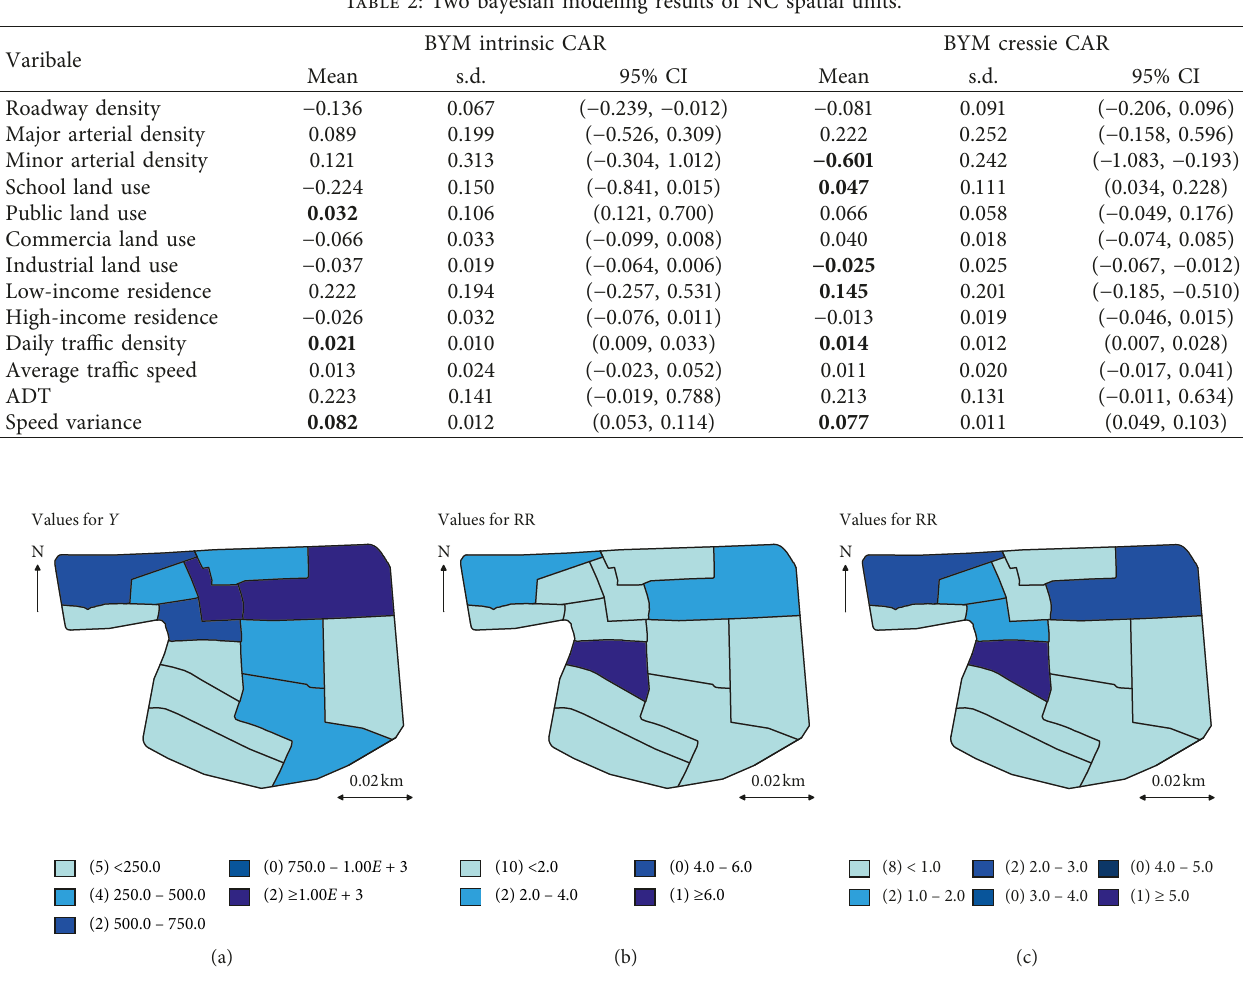
Table 2: Two bayesian modeling results of NC spatial units.